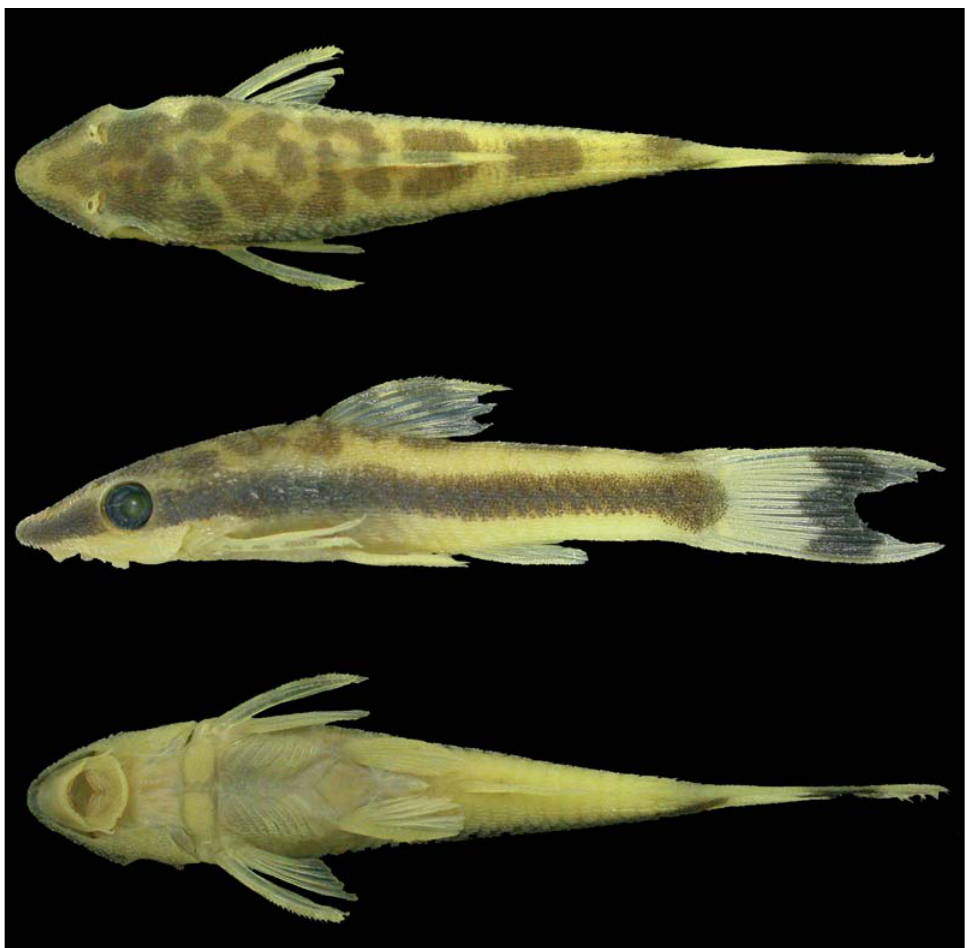
Fig. 1. Otocinclus batmani , ICNMHN 6721, holotype, male, 28.5 mm SL; Colombia, Amazonas, small stream tributary of Río Puré, Japurá drainage, upper Amazon